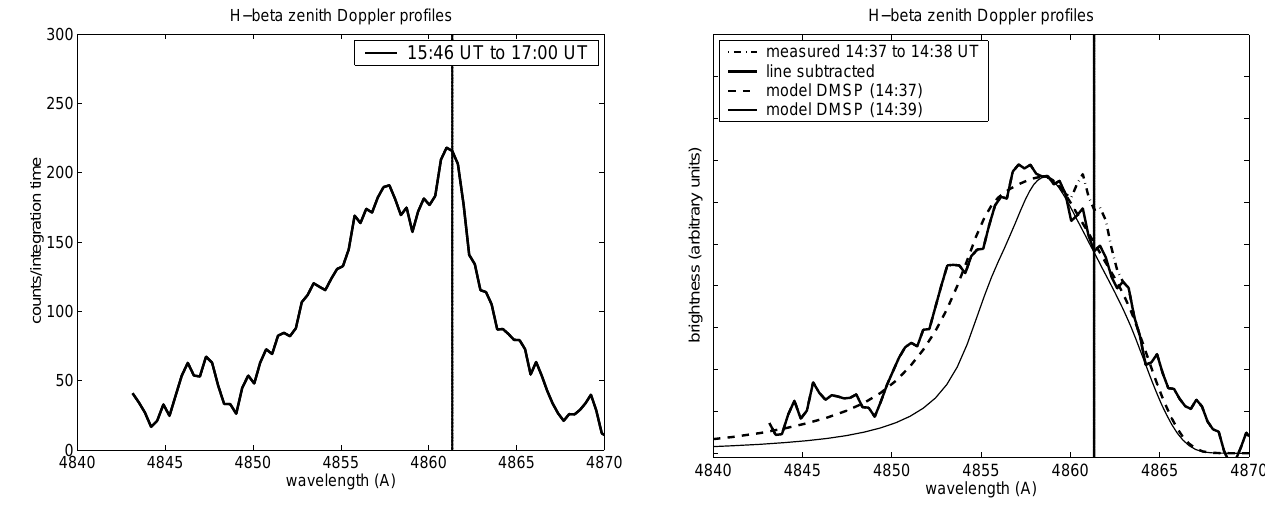
Fig. 7. Comparison of measured profile with modeled profiles using as input the spectra shown in Fig. 10. The dot-dash curve is the contribution of the unshifted line which has been removed in the solid